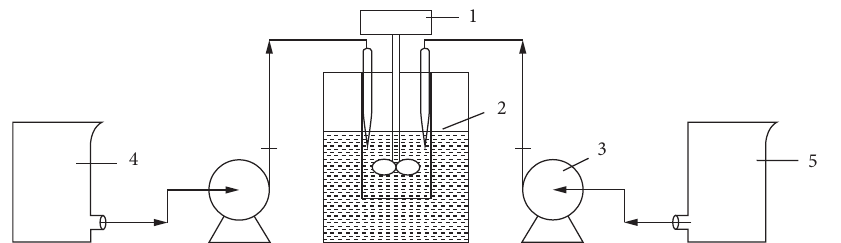
Figure 1: Experimental setup for stirred crystallization. 1, agitator; 2, crystallizer; 3, peristaltic pump; 4, mixed solution (aqueous phase); 5, extractant (oil phase).